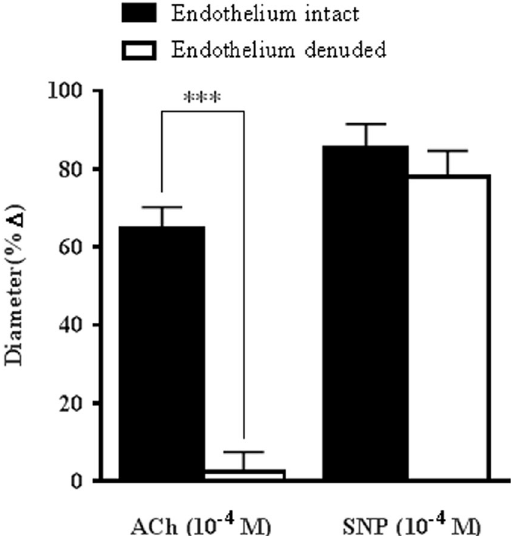
Figure 1. Role of endothelium in cholinergic vasodilatory responses of ophthalmic artery of eNOS − / − mice. Vasodilatory responses to ACh (10 − 4 M) were almost abolished in vessels denuded of endothelium. Conversely, vasodilation to exogenous NO donor, SNP (10 − 4 M) was preserved in both endothelium-denuded and -intact vessels. Values are expressed as mean ± standard error of the mean (s.e.m) (n = 6 per group; *** P < 0.001, endothelium-denuded versus